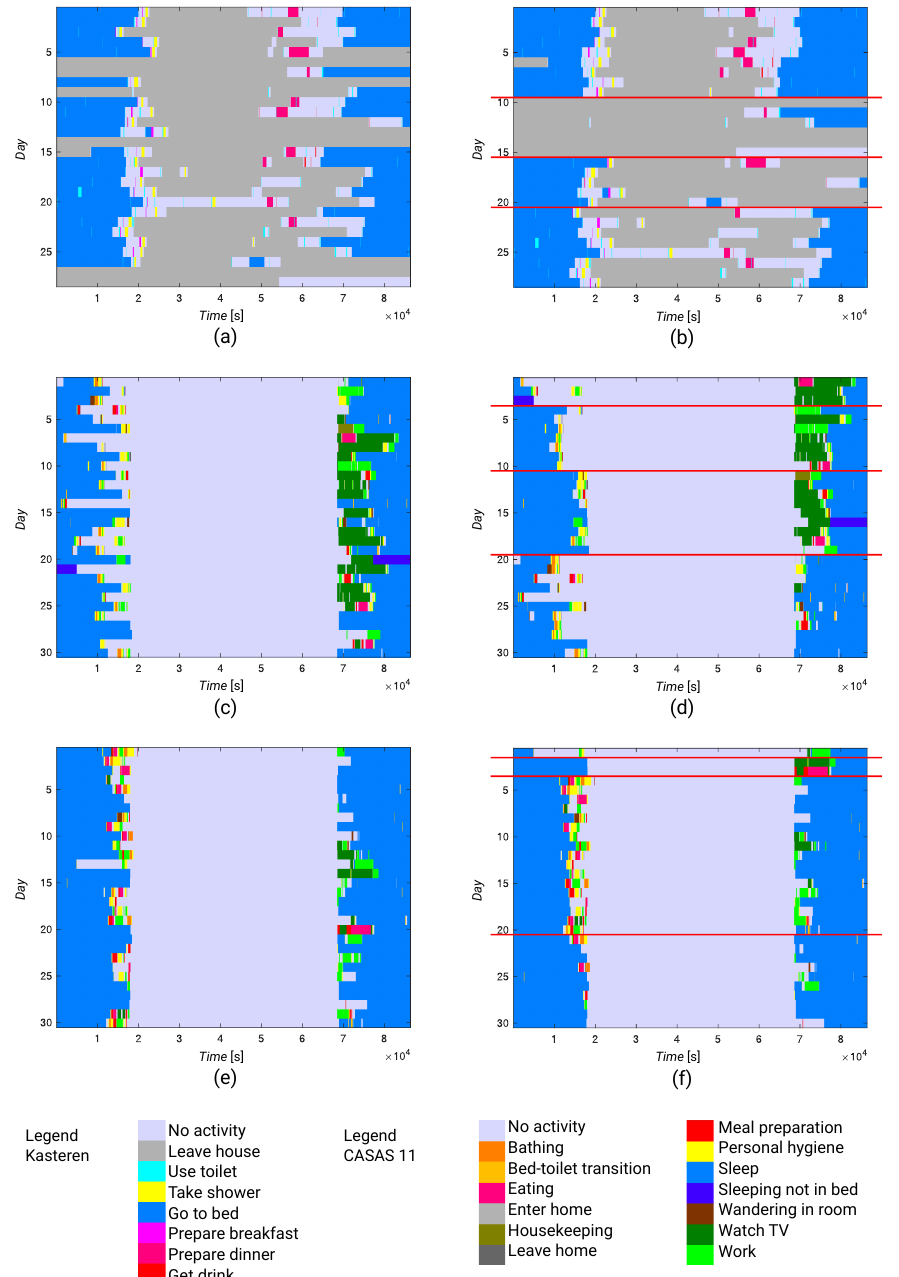
Figure 9. Daily activity representations of the resident in the ( a ) Kasteren dataset, consecutive days; ( b ) Kasteren dataset, partitioned on daily activity vectors; ( c ) CASAS 11 dataset, first resident, consecutive days; ( d ) CASAS 11 dataset, first resident, partitioned on daily activity vectors; ( e ) CASAS 11 dataset, second resident, consecutive days; and ( f ) CASAS 11 dataset, second resident, partitioned on daily activity